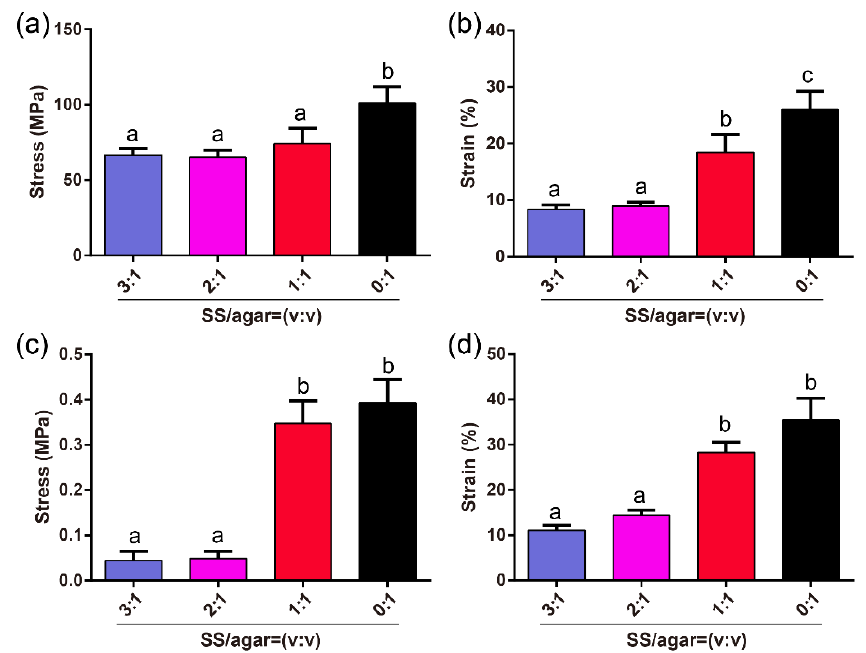
Figure 2. Mechanical properties of the SS/agar films with different ratios (SS: agar = 3:1, 2:1, 1:1, 0:1). The stress of the SS/agar film in a dry state ( a ) and wet state ( c ); The strain of the SS/agar film in a dry state ( b ) and wet state ( d ). For statistical analysis, the bars that are labeled with different lowercase letters (a, b, c) are significantly different, and the same letter indicates no significant difference ( p < 0.05).